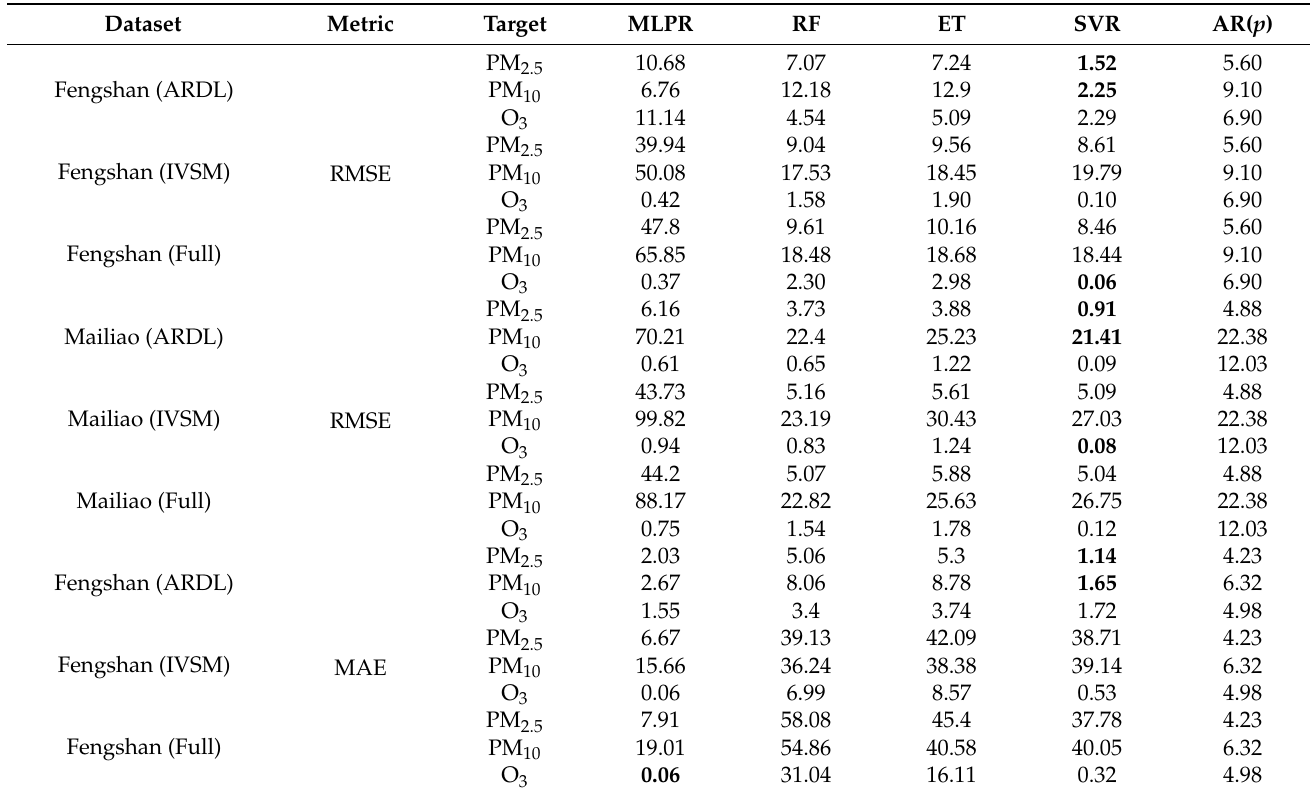
Table 8. Forecast results of PM 2.5 , PM 10 , and O 3 for ARDL and IVSM-selected variables and AR( p